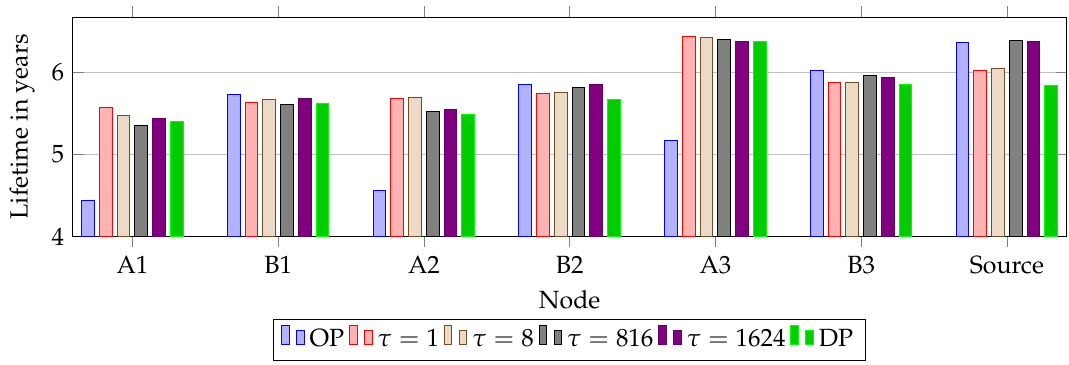
Figure 12. Scenarios and their average node lifetimes in years (Note: y-axis starts at 4 years). All simulations show a correlation between lifetime and where the upstream copy was eliminated.